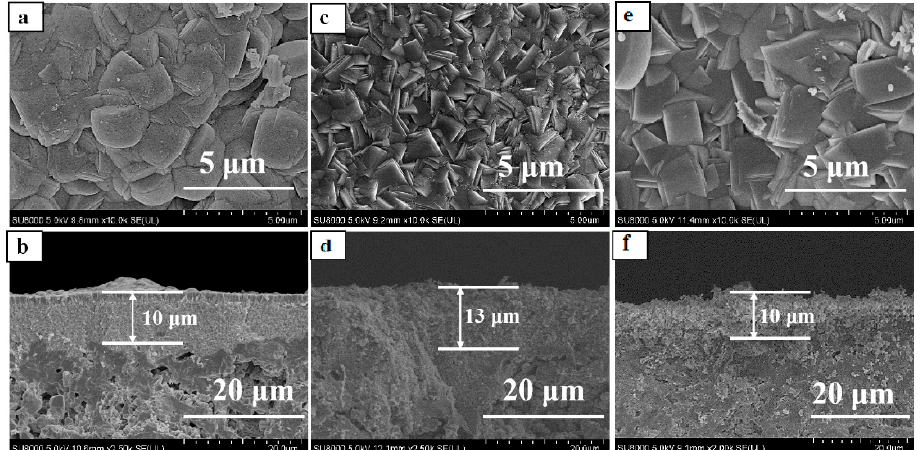
Figure 9. Surface and cross-section SEM images for the TS-1 membranes prepared with different seeded crystal suspension concentrations. ( a , b ) 2%, M-7; ( c , d ) 3%, M-8; ( e , f ) 7%, M-9.